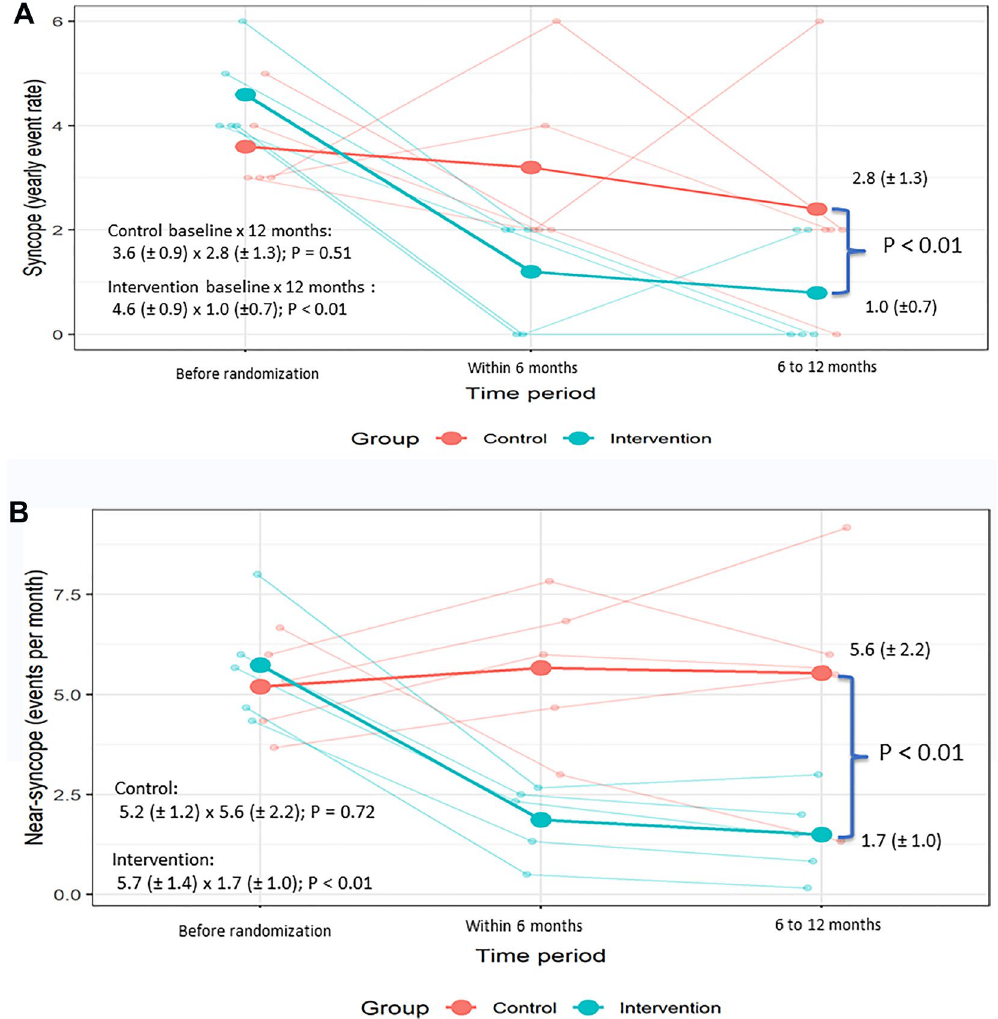
represents the average of the group (each group is identified by a different